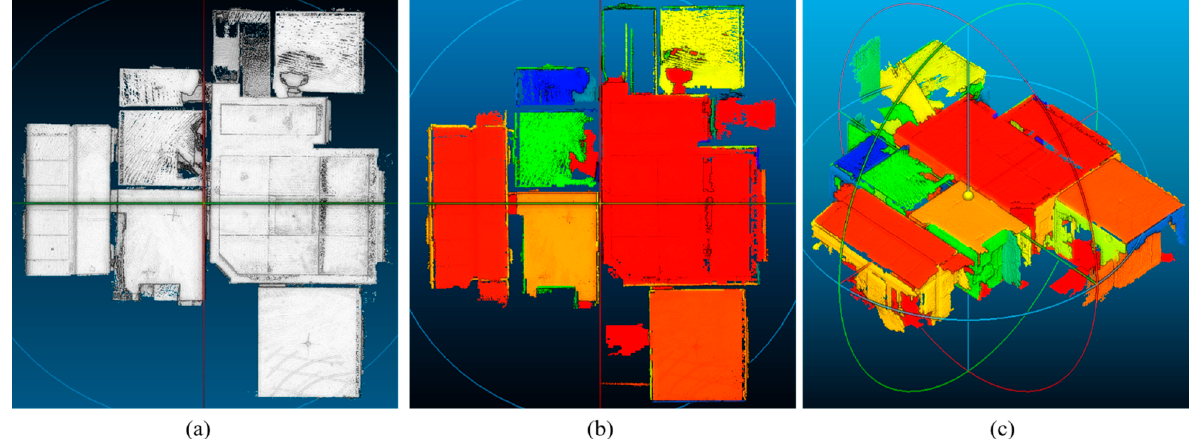
Figure 12. Implementation results of Dataset #1. ( a ) Raw PCD; ( b ) Top view of detected building components; ( c ) Front isometric view of detected building components.